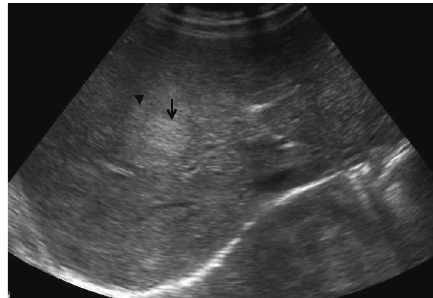
Figure 4: A 9-year-old boy with bleeding per rectum since he was 1 year old. A well-defined slightly hyperechoic lesion (arrow) with subtle hyperechoic rim (arrow head) is seen. This refers to carol atoll sign in nodular regenerative hyperplasia.